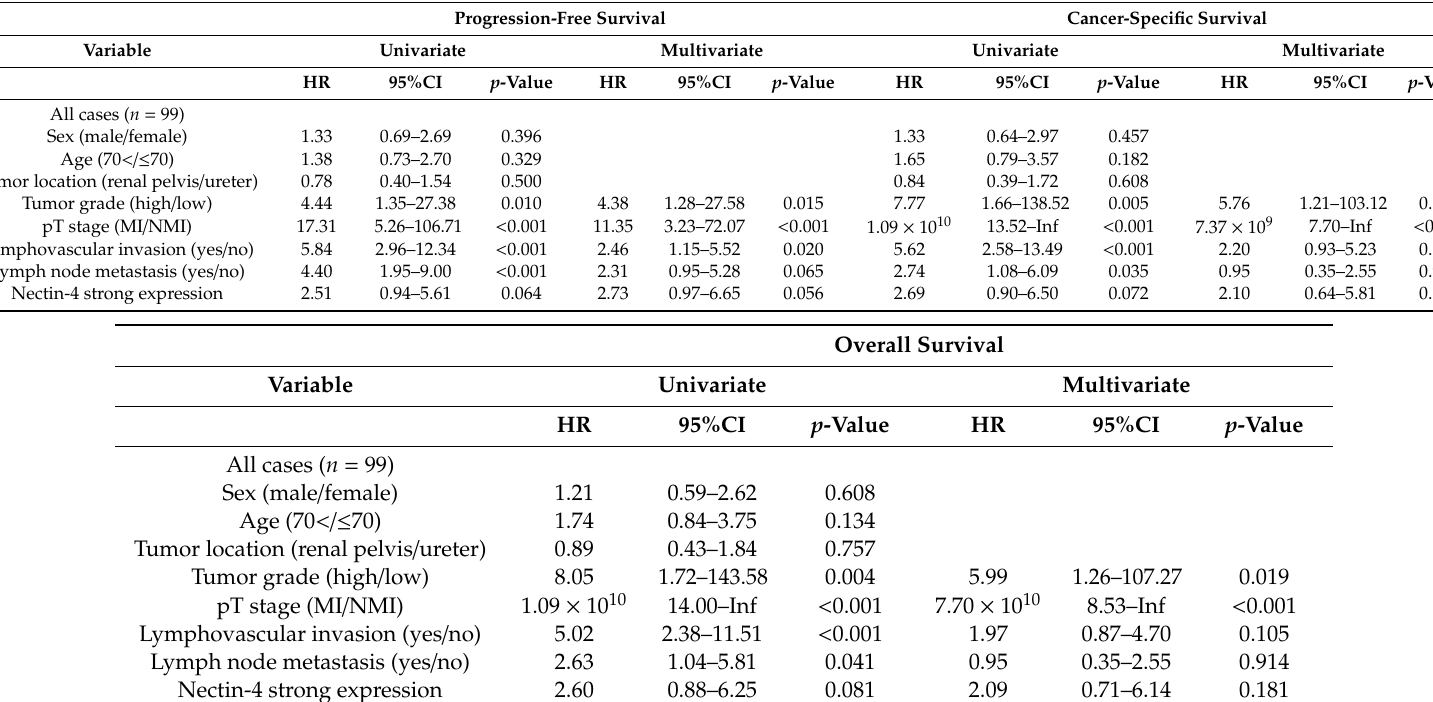
Table 3. Univariate and multivariate analyses of progression-free survival, cancer-specific survival, and overall survival in patients with UTUC. Progression-Free Survival Cancer-Specific Survival Variable Univariate Multivariate Univariate Multivariate